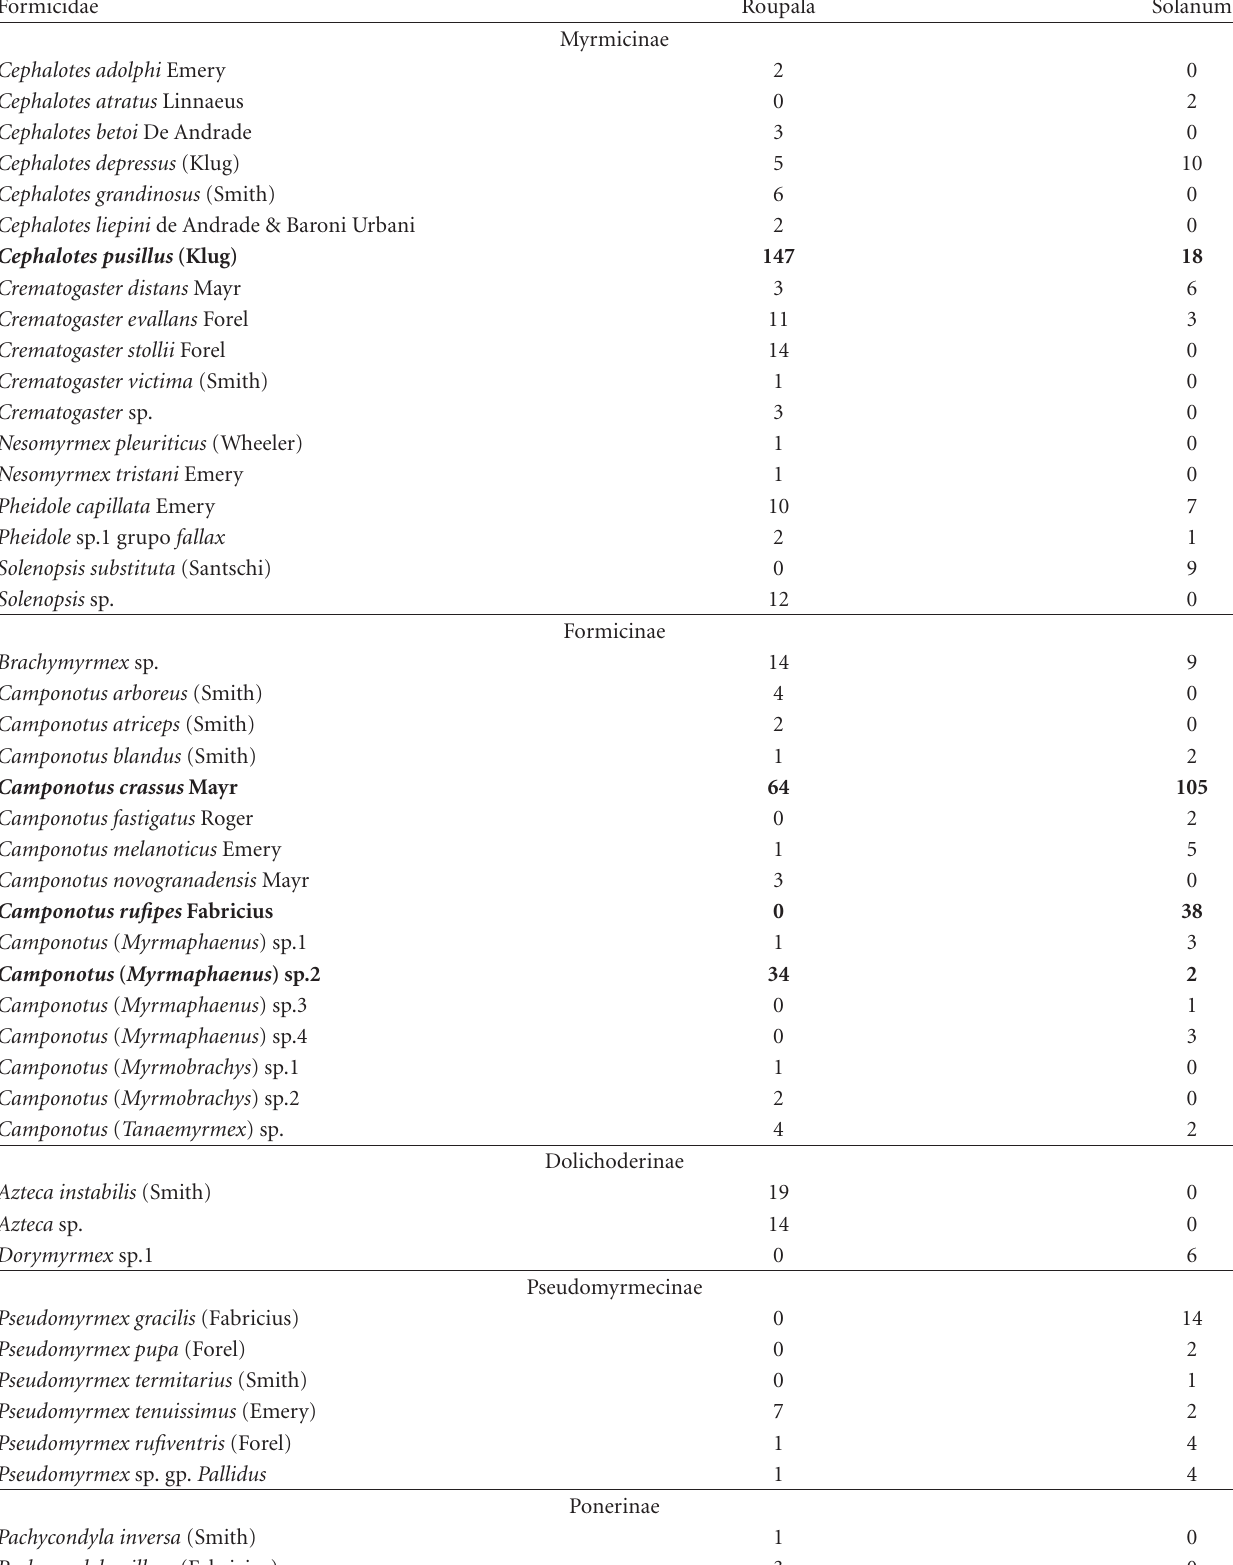
Table 2: Ant species and its occurrence on Roupala montana (Proteaceae) and Solanum lycocarpum (Solanaceae), in Fazenda Agua Limpa, Federal District, Brazil. The most frequent species are highlighted. Formicidae